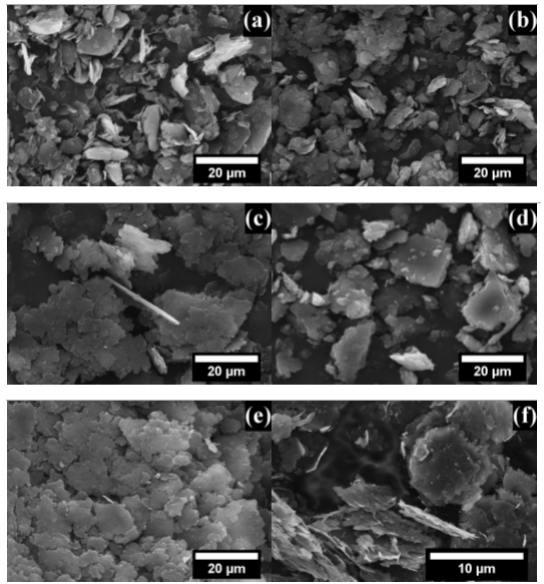
Figure 1. SEM micrographs of different samples milled by attritor: (a) starting graphite, (b) MA – Mild milling in Air, (c) MW – Mild milling in Water, (d) IA – Intensive milling in Air, (e) IW – Intensive milling in Water, (f) IE6 – 6 hours of Intensive milling in Ethanol